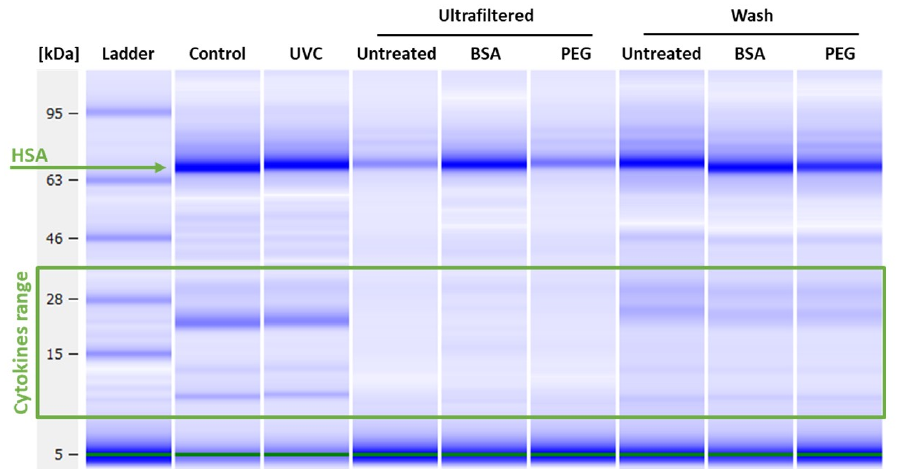
Figure 1. Digital electrophoresis of the viral samples decontaminated with UVC irradiation or ultrafiltration using 100 kDa filters, or filters pre-treated with BSA, or PEG600. Following the centrifugation step, the filters have been washed with PBS and the collected washing solution was analysed (Wash).